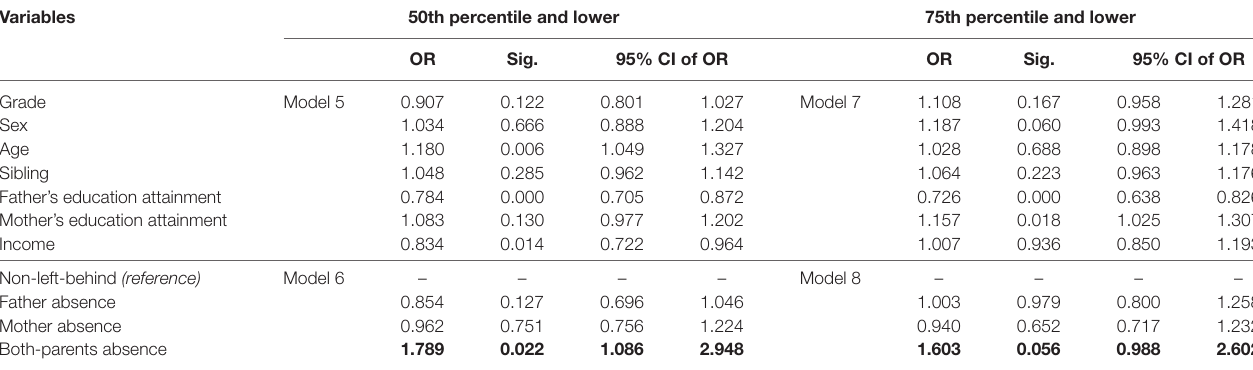
TaBle 3 | Logistic regression models for predicting lower scores in mathematics tests.